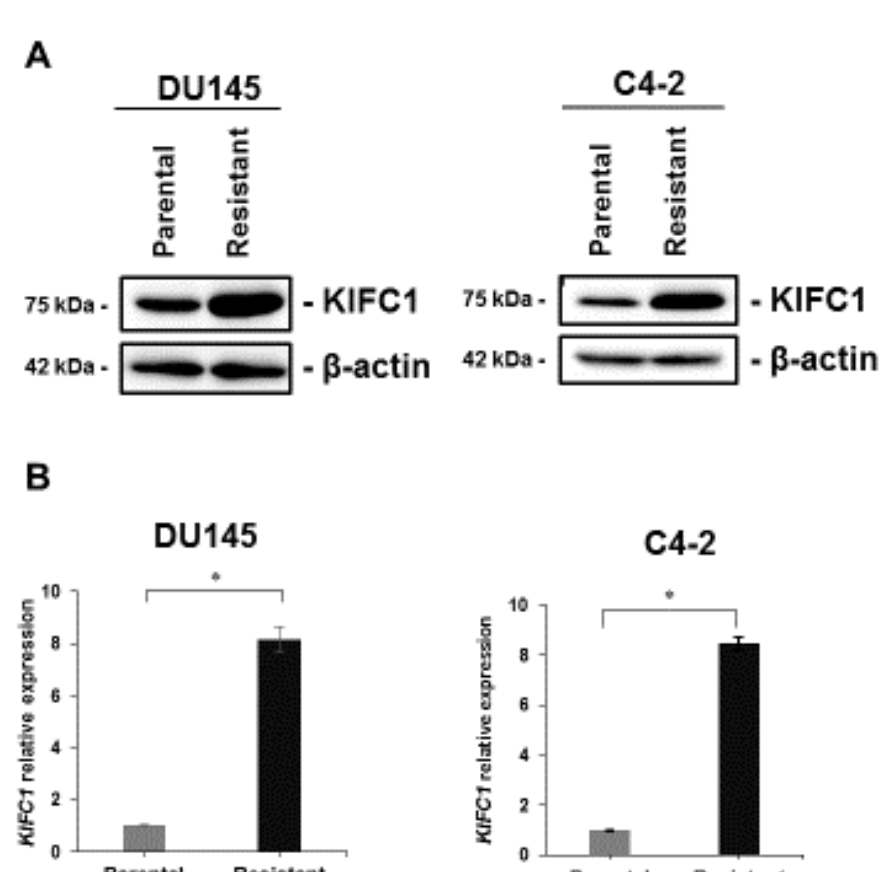
Figure 2. KIFC1 is overexpressed in docetaxel (DTX)-resistant cell lines and in a castration-resistant prostate cancer (CRPC) patient. ( A ) Western blotting of KIFC1 in parental and DTX-resistant cell lines. β-actin was used as a loading control. ( B ) qRT-PCR of KIFC1 in parental and DTX-resistant cell lines. The results are expressed as the mean and S.D. of triplicate measurements. * p < 0.01.